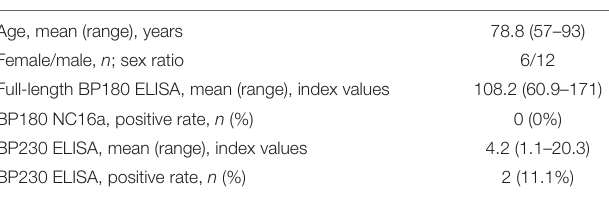
TABLE 2 | Summary of patient attributes. TABLE 3 | DPP4i